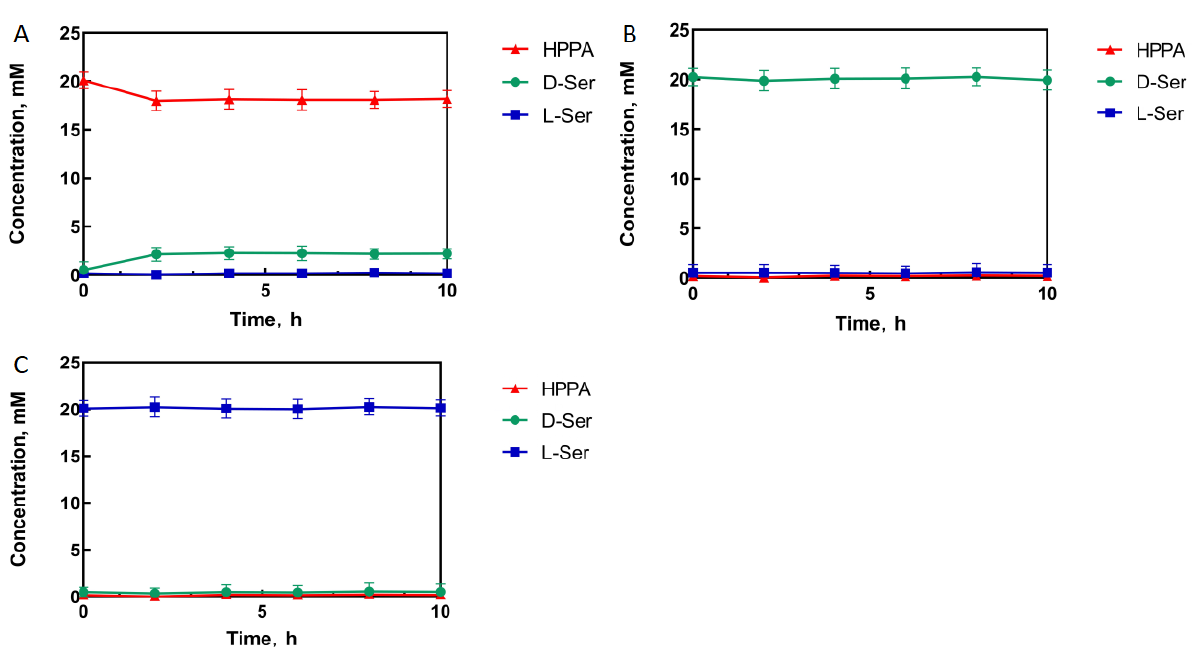
Figure 1. StDAPDH/H227V catalytic process with hydroxypyruvate ( A ), D-serine (D-Ser) ( B ), and L-serine (L-Ser) ( C ) as substrates, respectively.